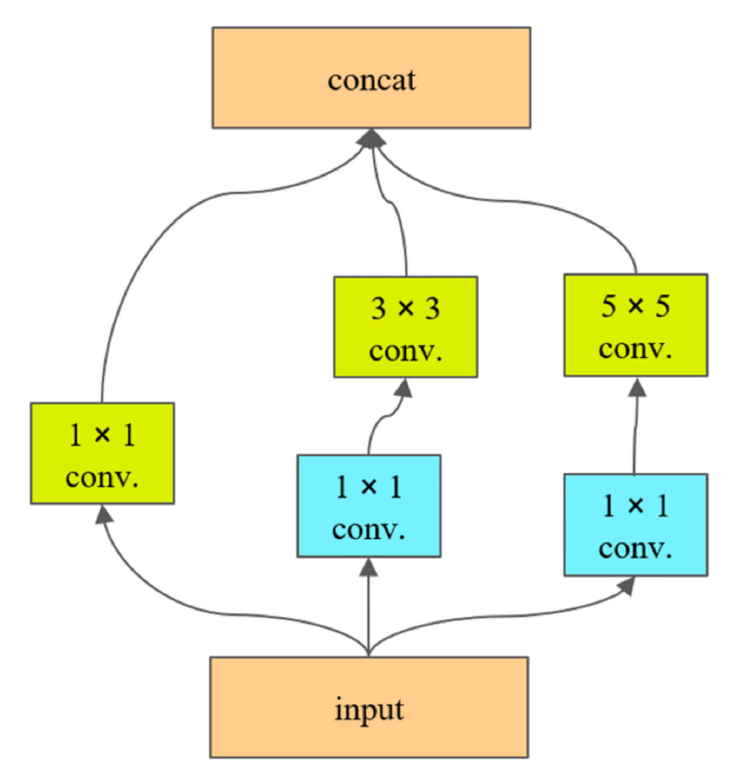
Figure 2. Multiscale feature extraction and fusion